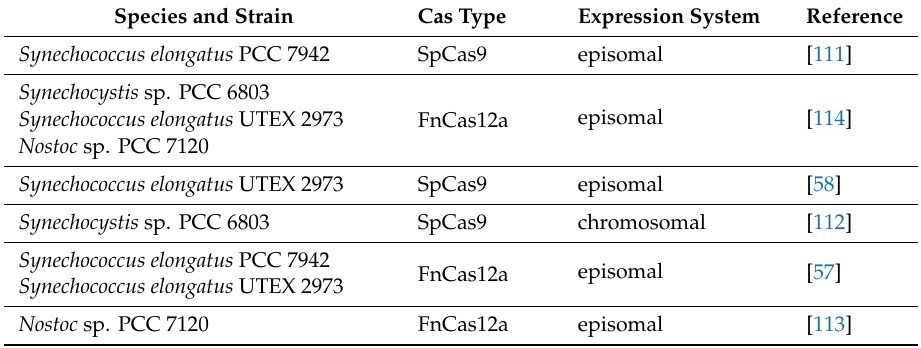
Table 3. Cyanobacterial species where CRISPR / Cas has been used for gene